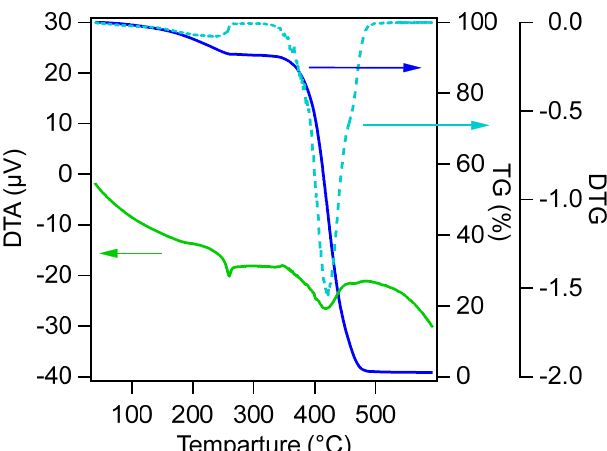
Figure 2. DTA and TG curves for PA66 at a heating rate of 10 °C/min under inert nitrogen atmosphere. The DTG curve was obtained by differentiating the TG curve.